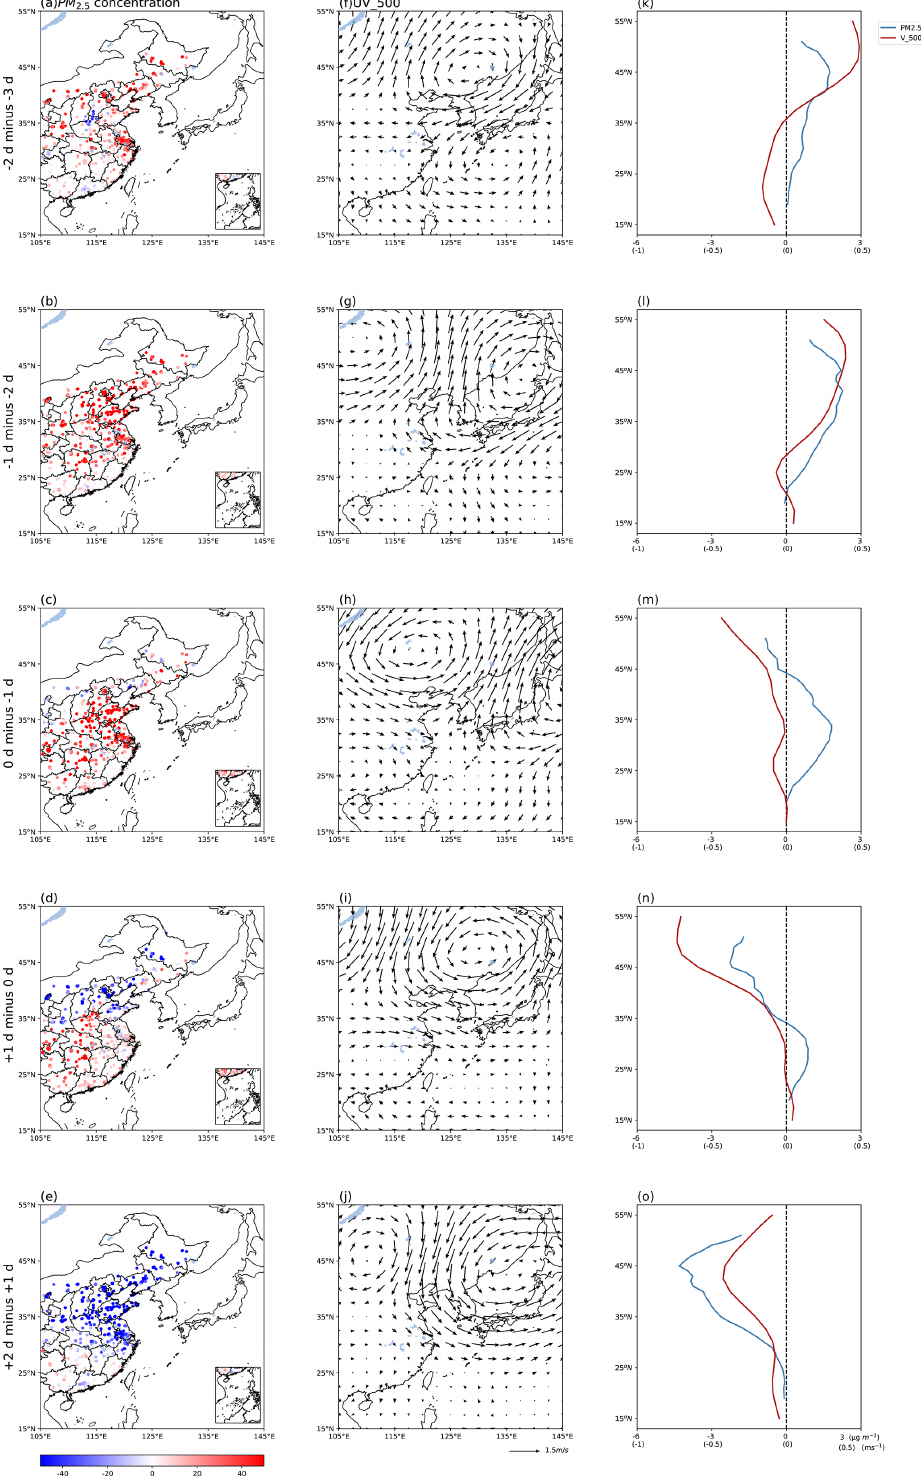
Figure 5. Composite anomalies of (a–e) the spatial distribution of PM 2 . 5 concentrations (unit: µgm − 3 ) from − 3 to 2d related to Type1 severe HD EC occurrences and (f–j) the corresponding horizontal wind (unit: ms − 1 ) at 500hPa. Panels (k) – (o) show the zonal averaged PM 2 . 5 concentration variations (unit: µgm − 3 ) and meridional wind variations (unit: ms − 1 ) in the range of 15–55 ◦ N, 105–135 ◦ E.